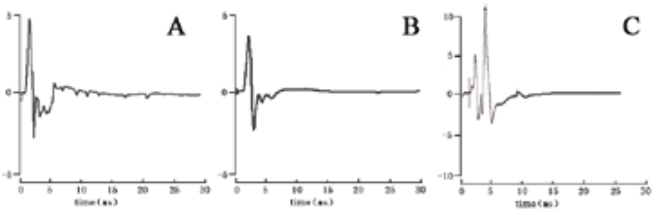
FIGURE 2 – A. Action potential of the affected side before paraplegia. B. Action potential of the affected side after paraplegia. C. Action potential of the intact side.